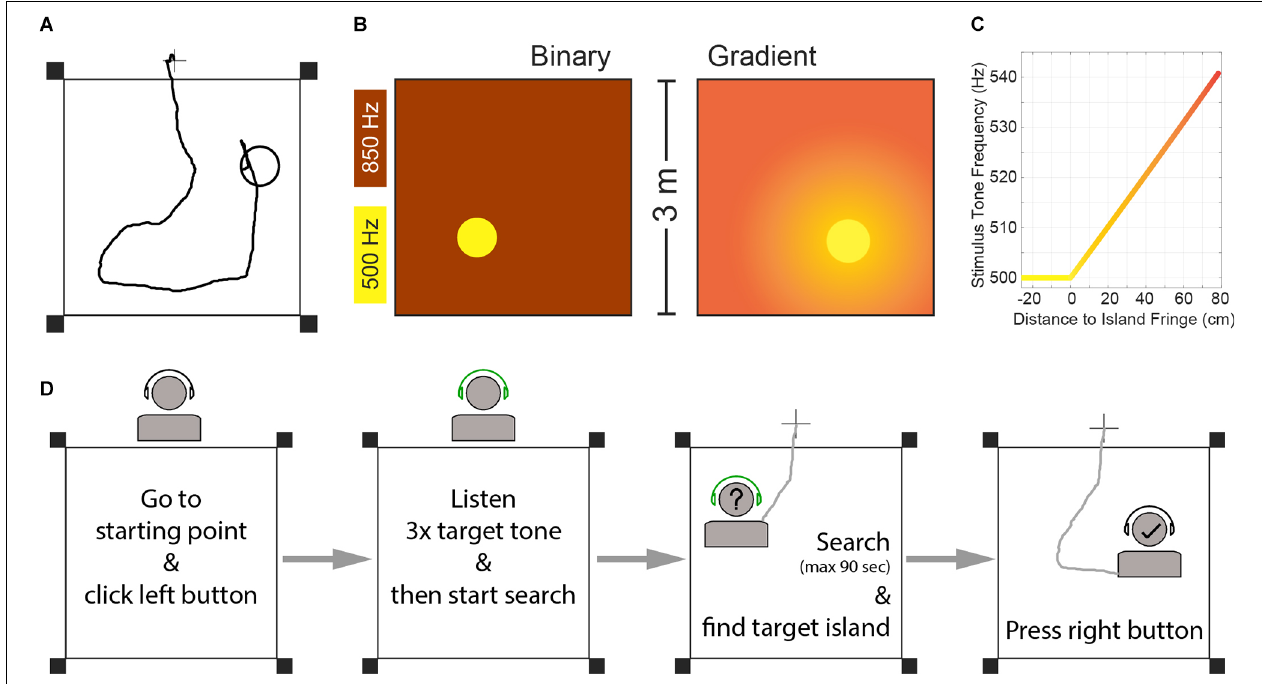
FIGURE 1 | (A) Example trial trajectory and schematic of the experimental arena for human SIT. The circle represents the target island (island radius was 26 cm). The cross outside the arena represents the starting point of each trial. Black squares represent the position of the Oculus Rift sensors. (B) Schematic representation of the two task versions. (C) Frequency of the stimulation tone pip as a function of the subject’s distance to the island fringe for the gradient task. Negative distance values denote positions inside the island. Note: The gradient did not finish at 80 cm distance, but extended over the whole arena. See “Materials and Methods” Section for the full relationship of gradient and distance-to-island. (D) Schematic flowchart of trial structure.